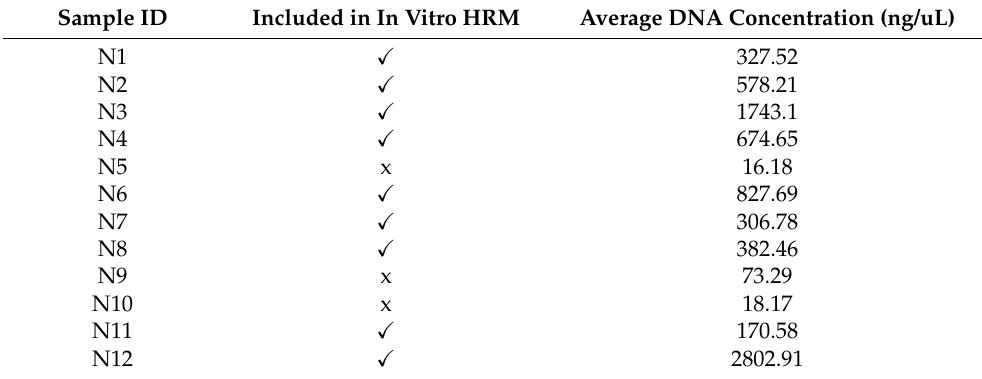
Table 2. DNA concentration of each sample.